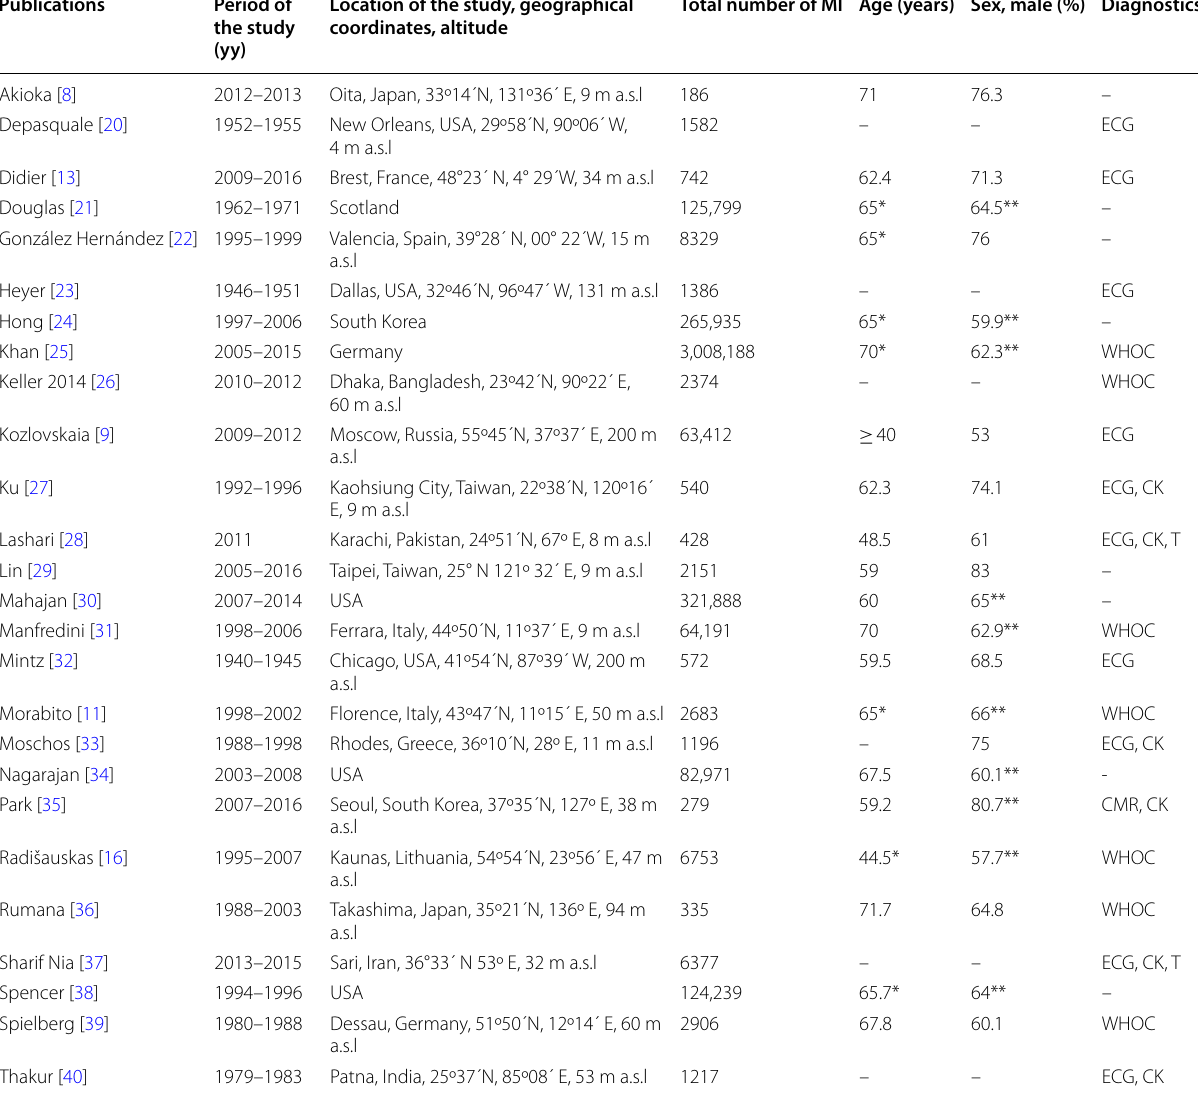
WHOC World Health Organization Criteria, ECG Electrocardiography, CK Creatine kinase, T Troponin, CMR Cardiovascular magnetic resonance * is statistics presented separately for groups of different ages, ** is statistics presented separately for men and women, and (-) is no information